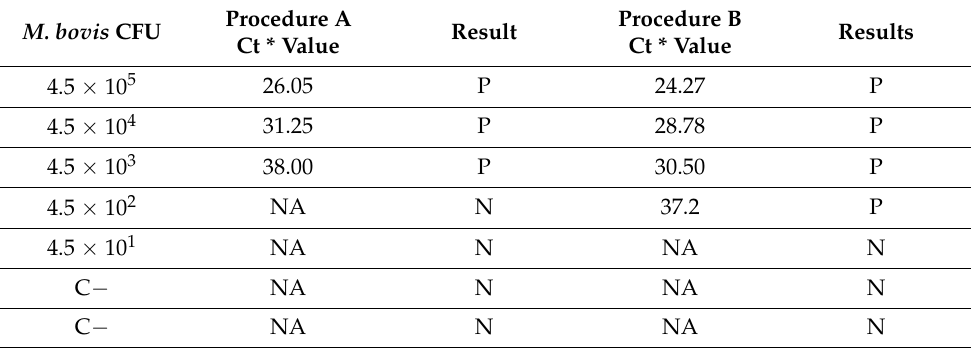
Table 2. IS6110 RT-PCR results, expressed in cycle threshold (Ct), of experimentally contaminated water samples (C − = negative control; P = positive; N = negative; NA = not amplified). * Ct values were calculated as the average of Ct replicate values.